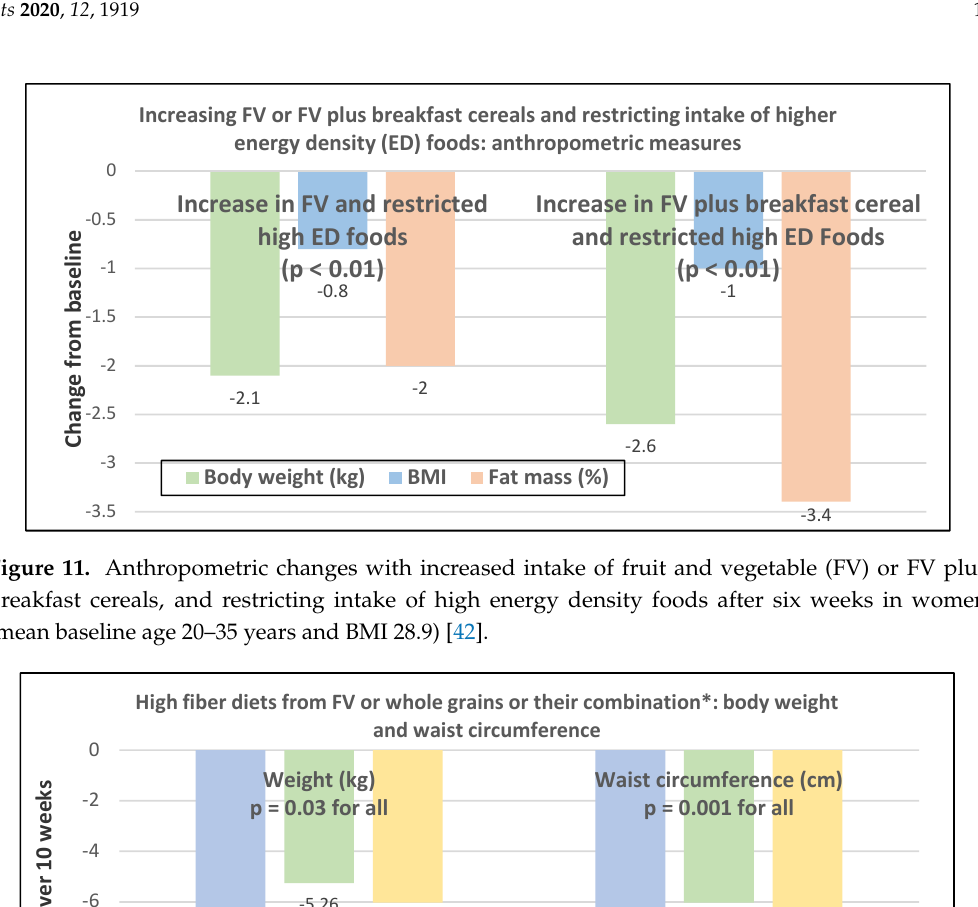
Figure 12. Change in weight and waist circumference in 75 obese women (mean age 37 years)